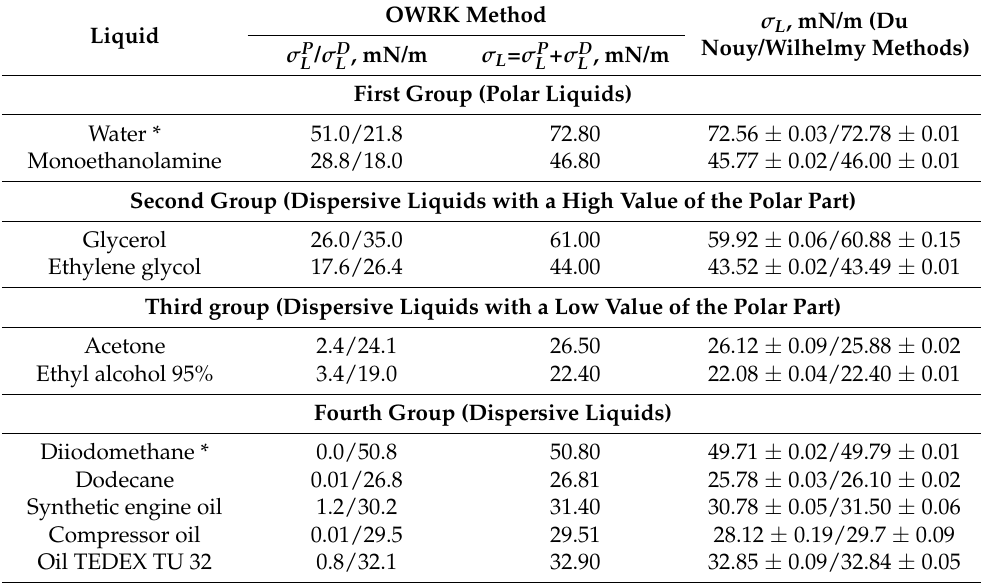
Table 3. Surface tensions of liquids determined by using the Du Nouy and Wilhelmy methods and the polar and dispersive parts of the surface tension and their sum determined by using the OWRK